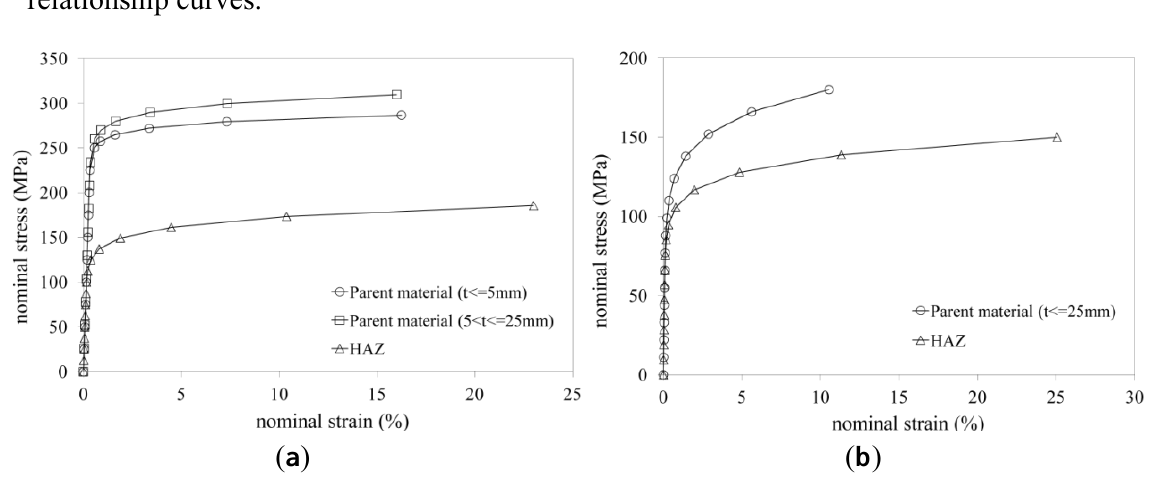
Figure 6. The ( a ) EN-AW 6082-T6; and ( b ) EN-AW 6061-T4 stress-strain constitutive relationship